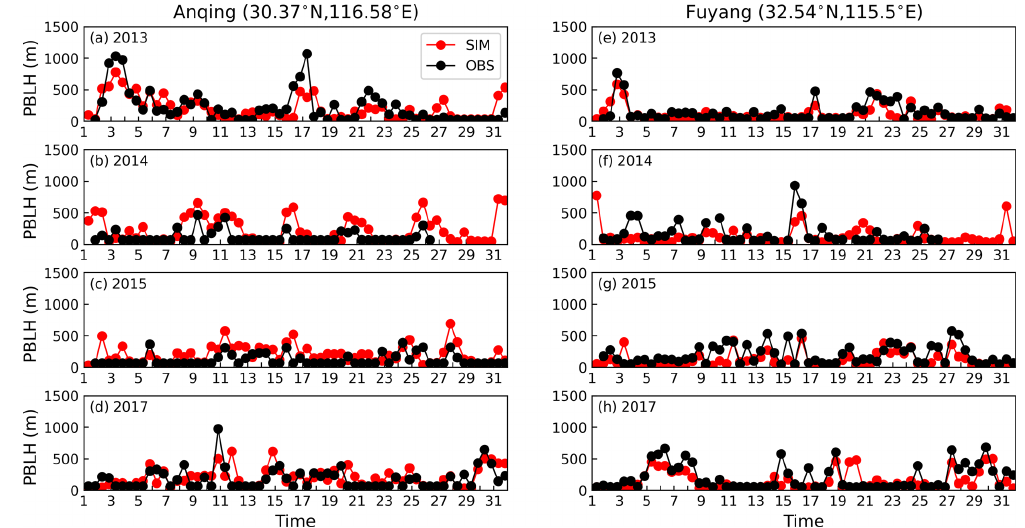
Figure 7. Time series of the observed (black) and simulated (red) PBLH at 08:00 and 20:00 (BJT) in (a–d) Anqing and (e–h) Fuyang from 2013 to